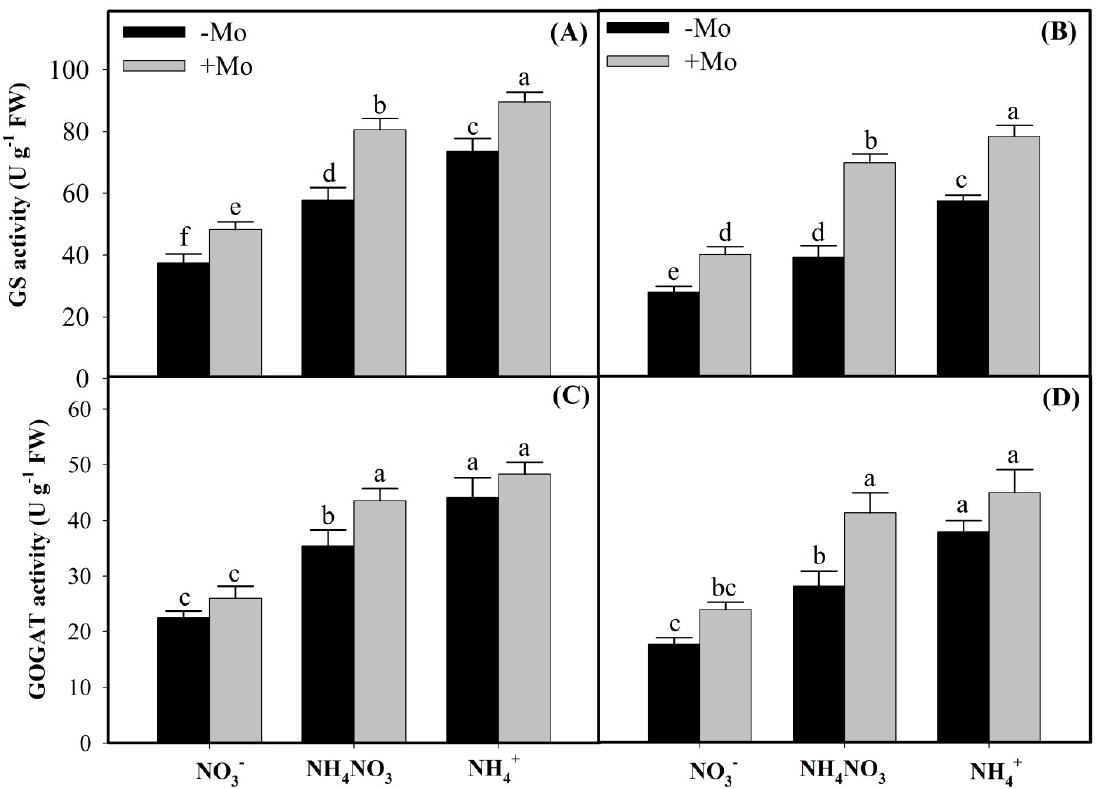
Figure 2. Impacts of Molybdenum (Mo) application on glutamine synthetase (GS) and glutamate synthase (GOGAT) activities in the leaves of Mo-efficient winter wheat ‘97003’ cultivar ( A,C ) and Mo-inefficient ‘97014’ cultivar ( B,D ) under different N sources. − Mo and +Mo treatments represent the 0 and 1 µM Mo [Na 2 MoO 4 .2H 2 O] concentrations, respectively, in Hoagland solution. Vertical bar above indicates standard error of four replicates. Different lowercase letters (a, b, c, etc.) represent significant differences according to the LSD-test ( p < 0.05, n = 4). Description of treatments is mentioned in Figure 1. Table 1. Influence of Mo supply on NO 3 − , NO 2 − , and NH 4 + contents in leaves of Mo-e ffi cient ‘97003’ and Mo-ine ffi cient ‘97014’ winter wheat cultivars under di ff erent N sources. Treatments